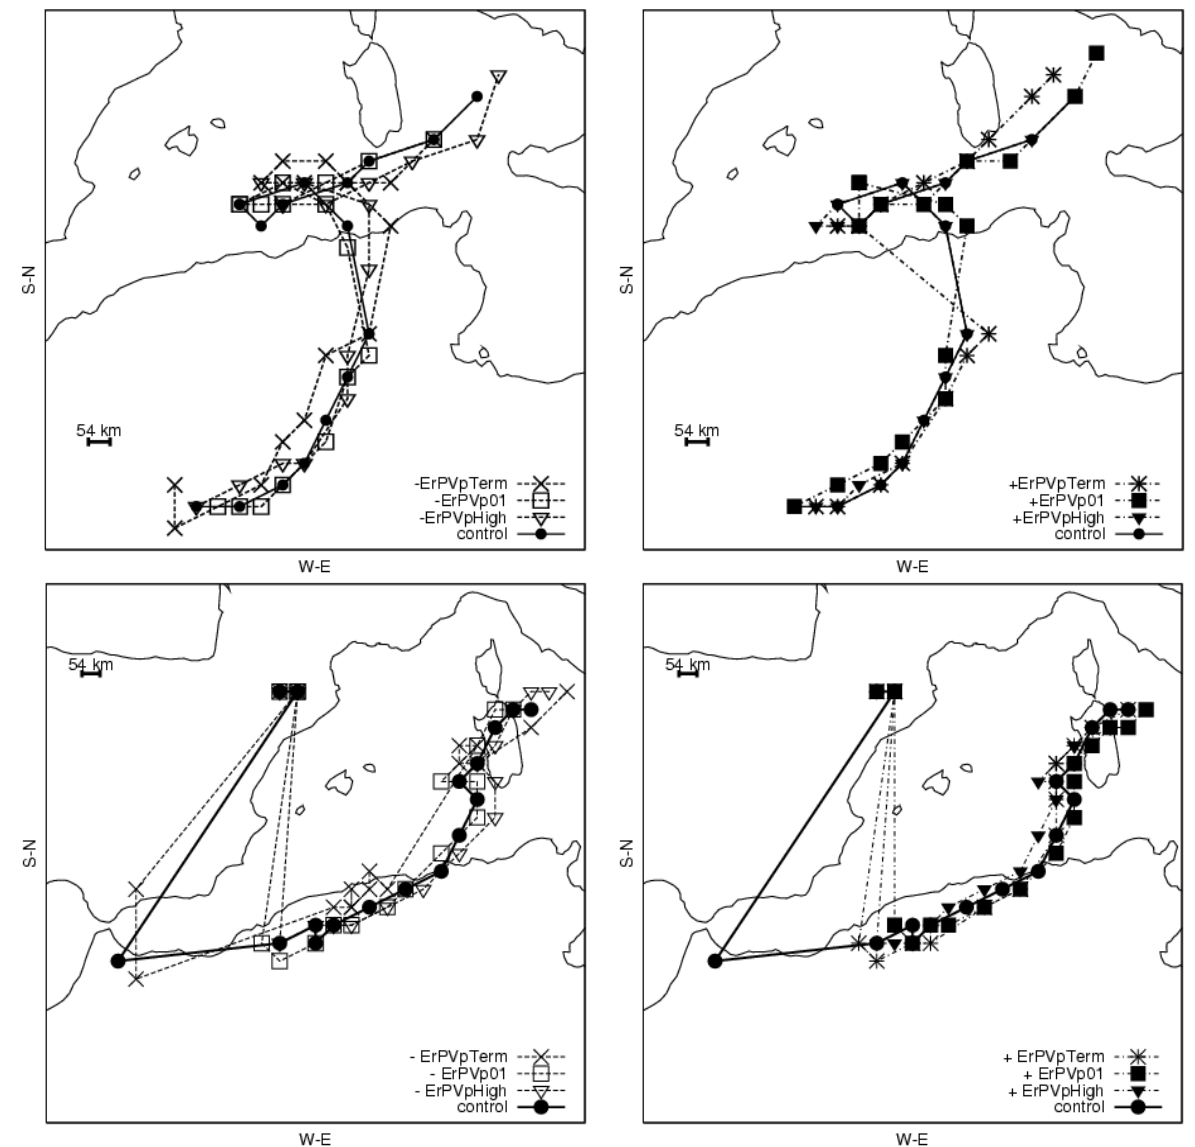
Fig. 11. Top panels: Trajectories of the cyclone obtained from the initially perturbed simulations. Bottom panels: Trajectory of C0 for the dif- ferent simulations. For the negative modifications (left), for the positive modifications (right). According to values on Table 1. − ErPVpTerm (simple cross), +ErPVpTerm (full cross), − ErPVp01 (empty square), +ErPVp01 (filled square), − ErPVpHigh (empty triangle), +ErPVpHigh (filled